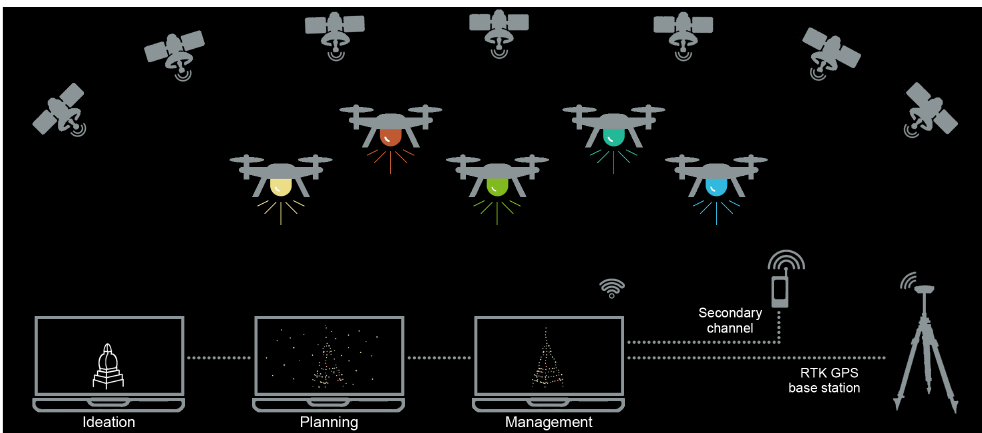
Fig. 12 Rosina Iaderosa, Methodological process and technologies used for drone light show ,